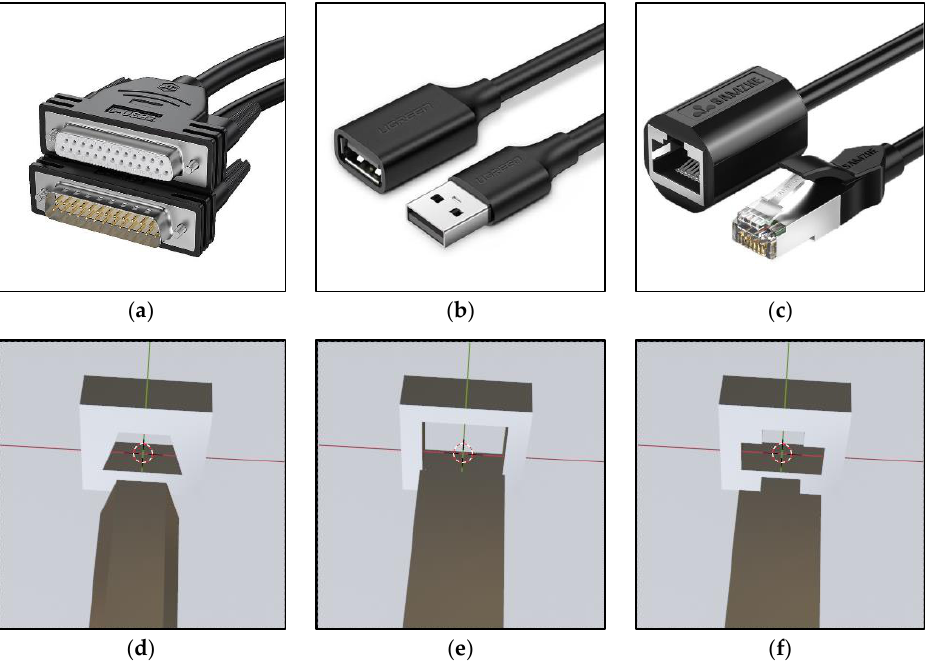
Figure 7. Common 3C connectors and polygon primitives. ( a ) DB-25. ( b ) USB. ( c ) RJ45. ( d ) Trapezoid. ( e ) Square. ( f ) Convex.